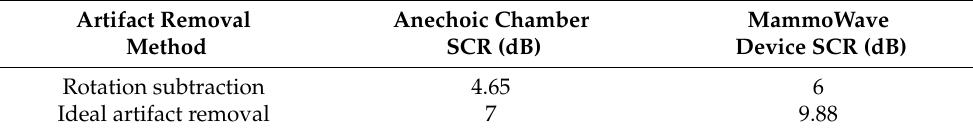
Table 2. SCR for microwave images of phantom measurements in both the anechoic chamber and MammoWave